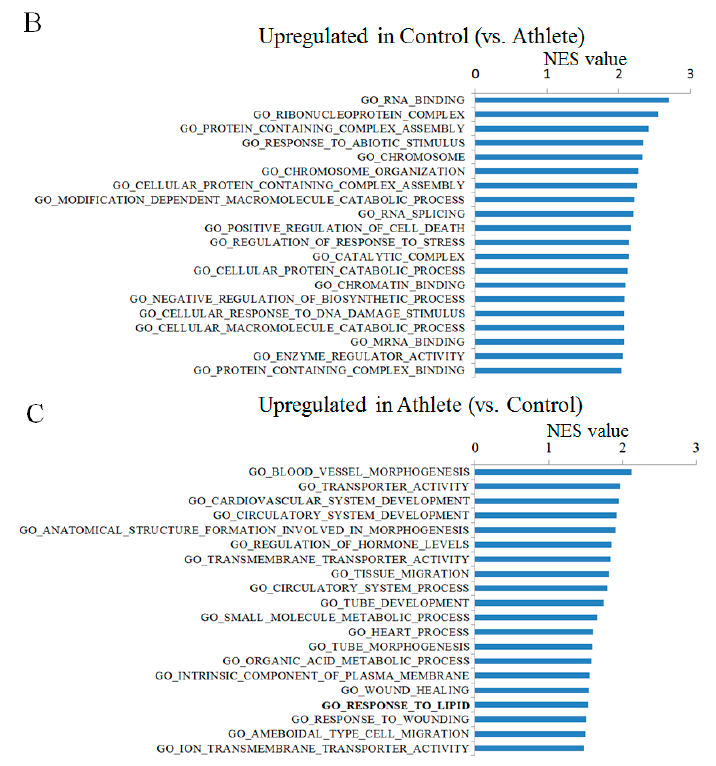
Figure 3. Microarray findings in the control and athlete groups. ( A ) Volcano plot comparing gene expression in the control versus athlete group. The x-axis indicates di ff erential expression profiles plotted in fold-induction ratios on the log 2 scale. The y-axis indicates the statistical significance of the difference in expression on the log 10 scale. Genes upregulated in the athlete group are shown in red. Genes downregulated in the athlete group are shown in blue. ( B ) The top 20 significantly upregulated Gene Ontology gene sets (c5.all.v2.5) based on GSEA in the control group. ( C ) The top 20 significantly upregulated Gene Ontology gene sets (c5.all.v2.5) based on GSEA in the athlete group. Gene set enrichment analysis; GSEA, Normalized enrichment score; NES.